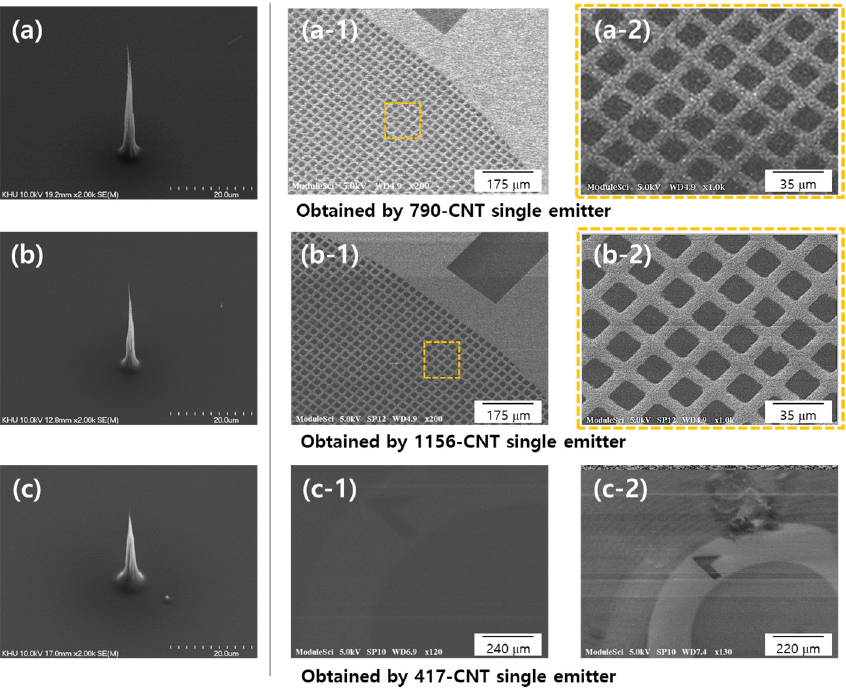
Figure 6. Comparison of scanning secondary electron images with structural properties of CNT cold cathodes. SEM images of a CNT cold cathode with: ( a ) β geo = 790, ∆ V = 1200 V; ( b ) β geo = 1560, ∆ V = 900 V; and ( c ) β ∆ V = 2100 V. ( a-1 – c-1 ) SEM images of Cu grid mesh (2000) at 5 kV geo = 417, acceleration voltage and 1 A emission current. ( a-2 ) A 1000 × magnified image of dashed square area in ( a-1 ). ( b-2 ) A 1000 × magnified image of dashed square area in ( b-1 ). ( c-2 ) SEM image obtained at 5 kV and 3 A emission